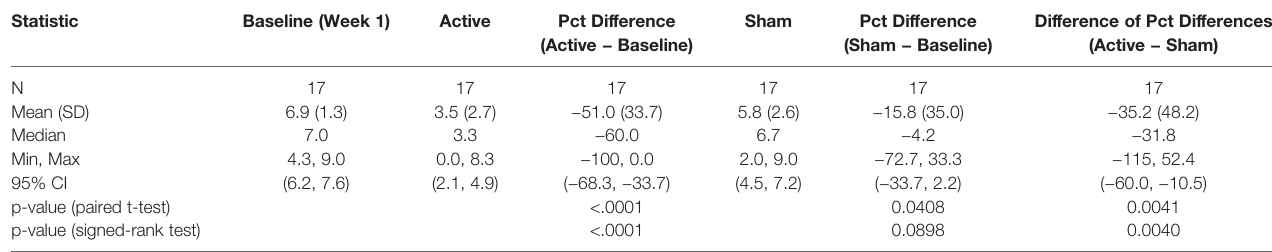
TABLE 3 | Comparison of mean OCS scores (percent change) between active and sham treatments one week after treatment. Statistic